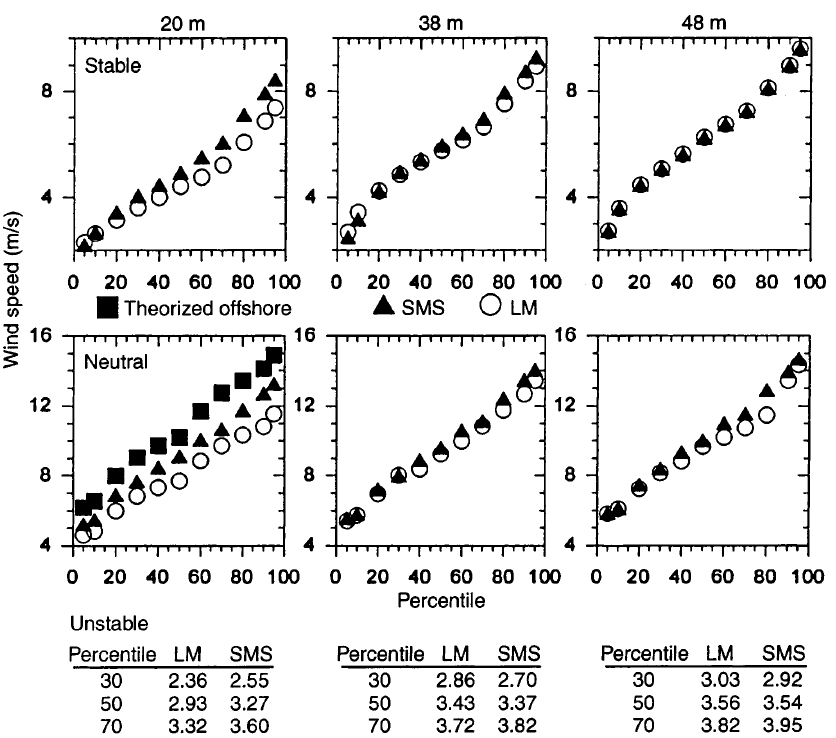
Fig. 3. Wind speed distributions (m/s) at 20, 38, and 48 m height from LM and SMS by s tability class for flow from the south sector. Also shown is a wind speed distri- bution at 20 m for near-neutral conditions derived theoretically, using the methodology described in the text. Because of the low number of observations in the unstable class the entire distribution may not be charac- terized and so the data for the 30 th , 50 th , and 70 th percentiles are shown in the box (note: Perc. =